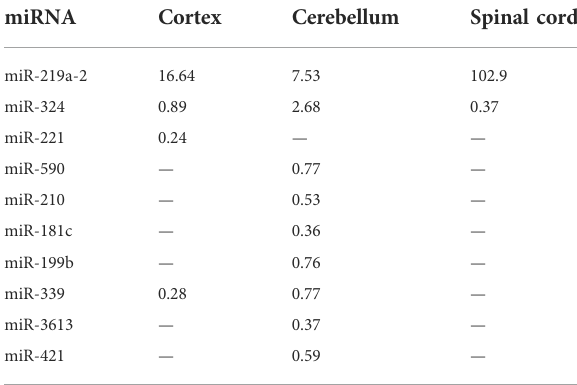
TABLE 2 miRNA gene expression in brain areas according to GTEX